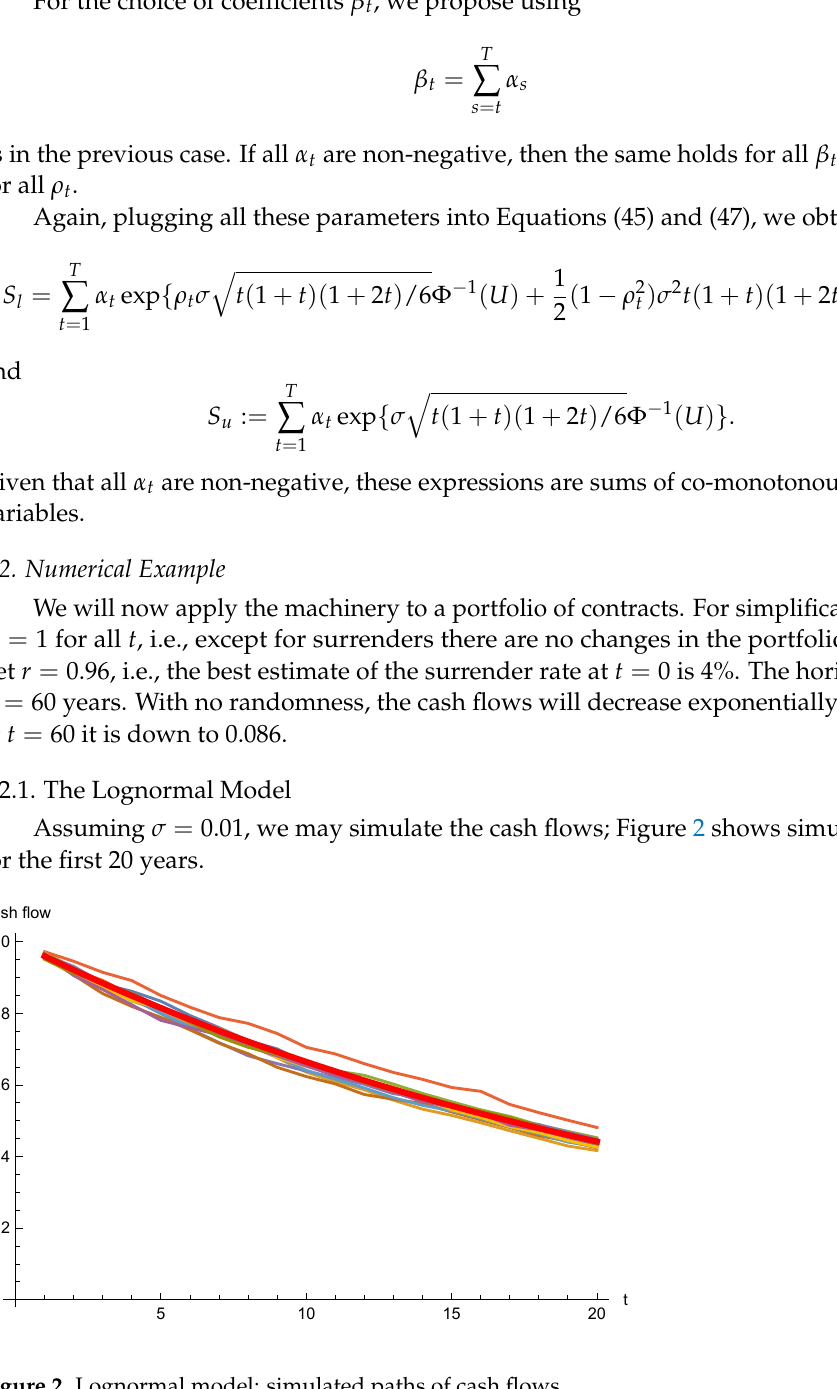
Figure 2. Lognormal model: simulated paths of cash